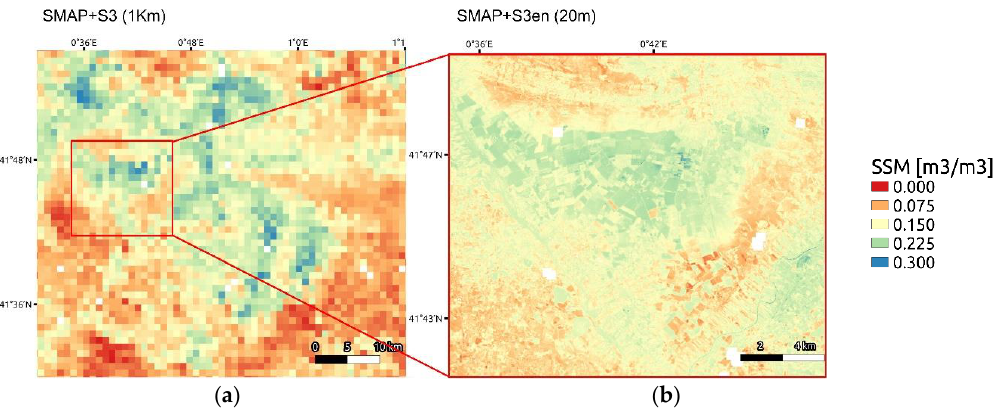
Figure 2. SSM map of the considered study area on 19 August 2017. ( a ) SMAP+S3 SSM map at 1 km resolution and ( b ) SMAP+S3en SSM map at 20 m resolution.